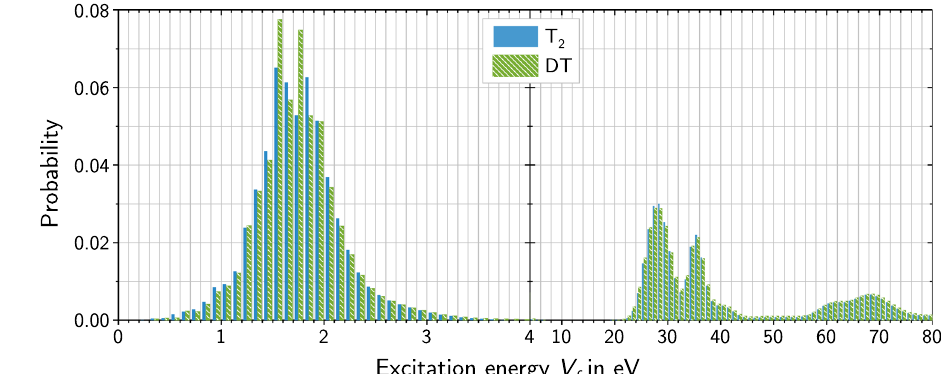
Fig. 3 Comparison of molecular final-state distributions of HeT + and HeD + . Sampled from [15,16] with a 0.1 eV binning for excitation energies V f ≤ 4 eV and a 1.0 eV binning for V f > 4 eV, summed over the initial angular momenta states 0 ≤ J ≤ 2 according to their population at a temperature of T = 30